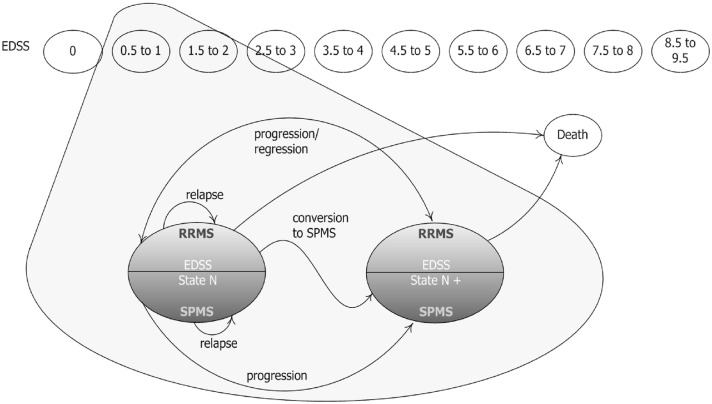
Model schematic.